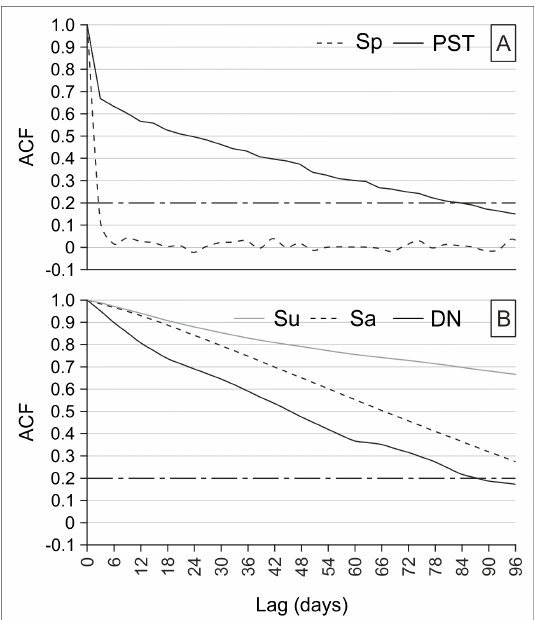
Figure 8. Autocorrelation functions: rainfall-river level ( A ); and piezometric levels ( B ). The dash-dotted line indicates the decorrelation threshold. The initials and the abbreviations refer to Table 1.